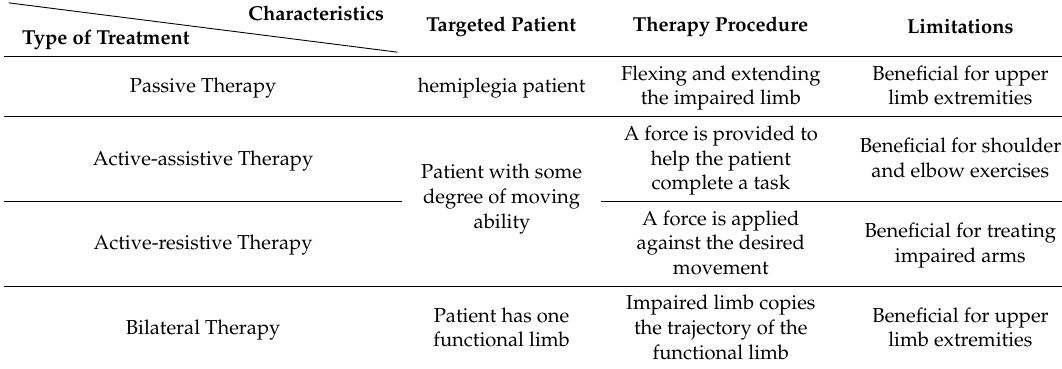
Table 1. Summary of the therapy types in terms of targeted patient, therapy procedure and limitations.